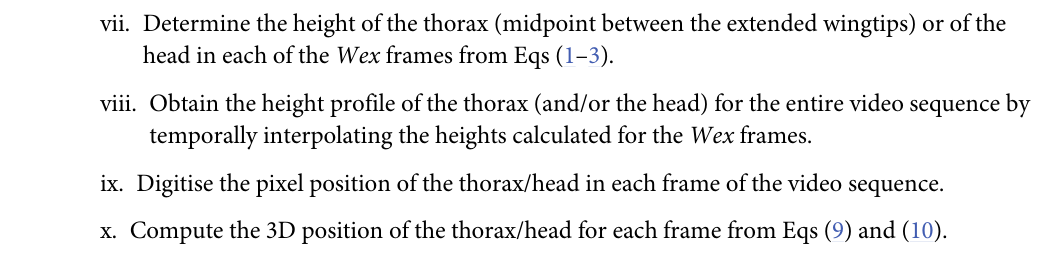
Fig 4. Video of a flight. Example of a video sequence showing superimposed images of the bird in successive frames. Successive wing extensions are marked by the crosses.